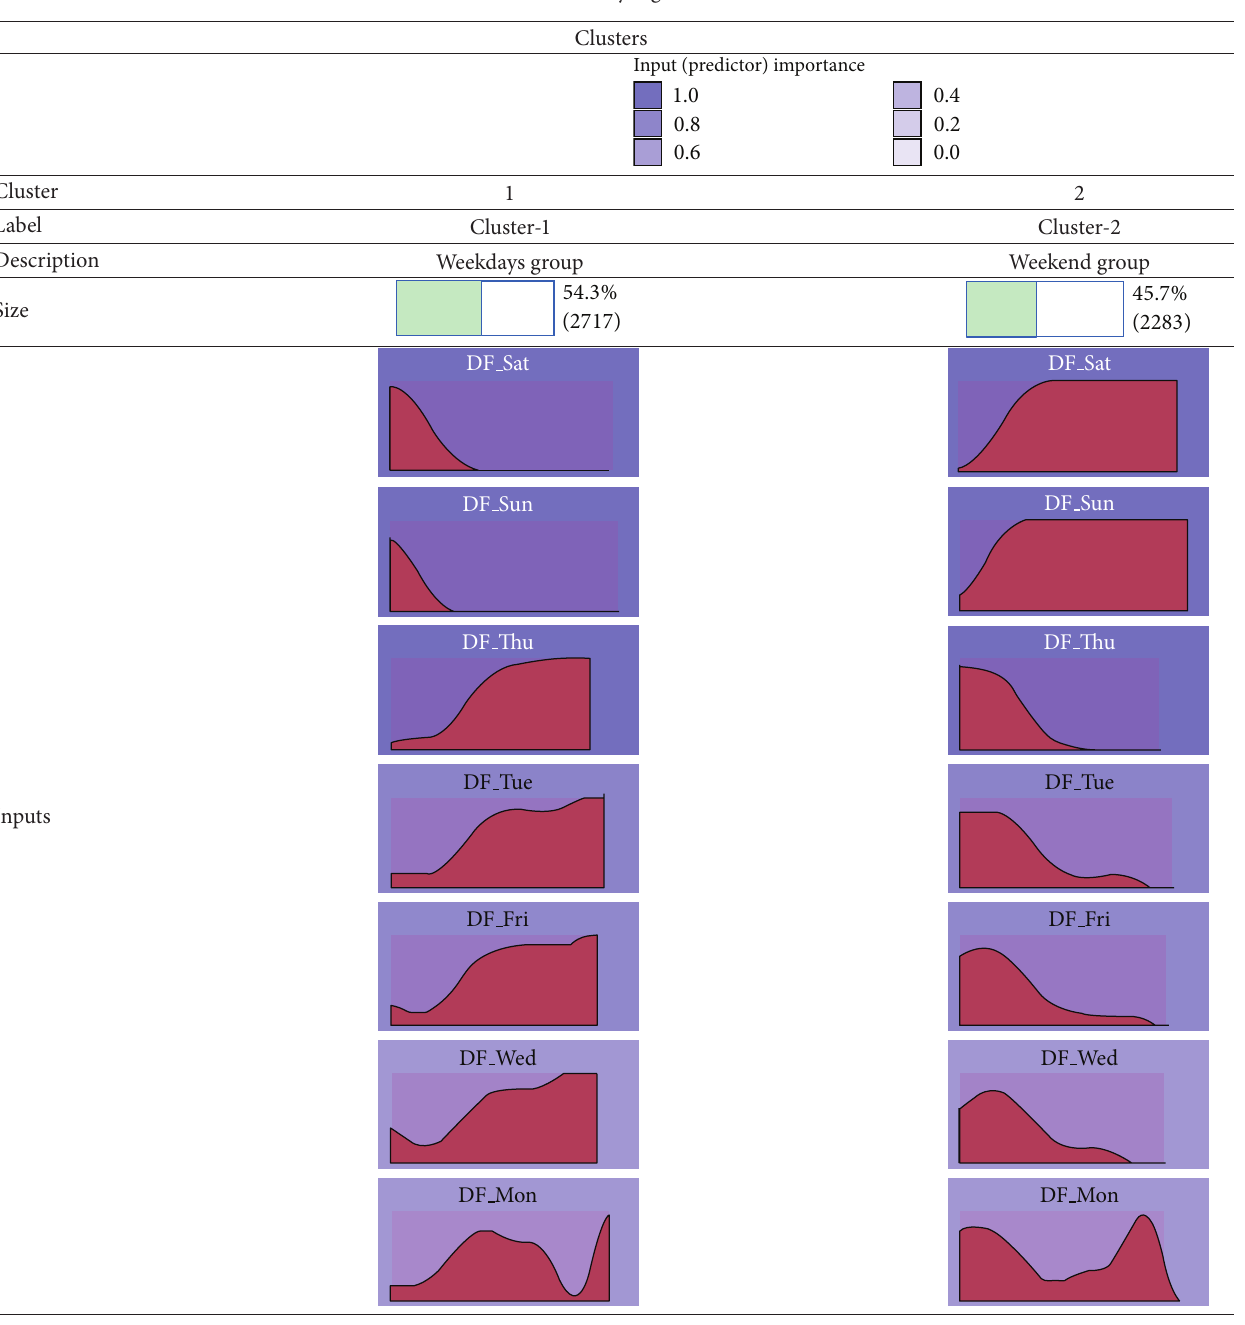
Table 4: Weekday